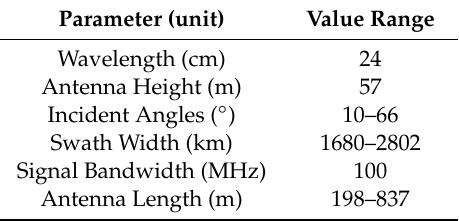
Table 2. Typical parameters of global change observation lunar based SAR (GCOLB-SAR) (Partial).